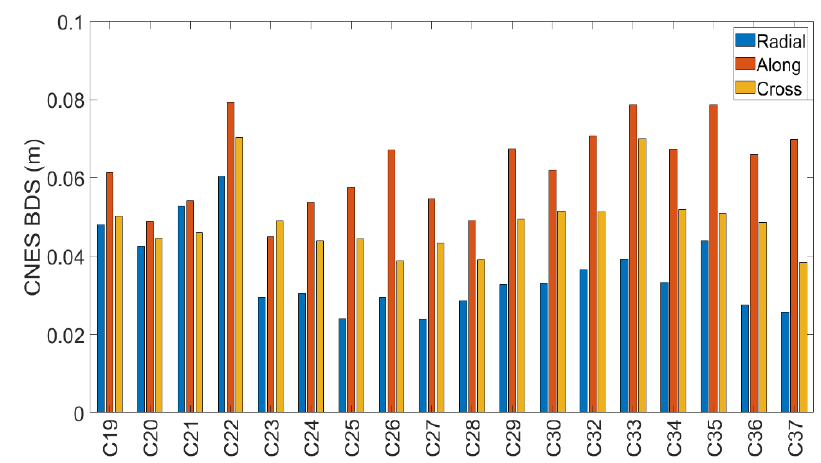
Figure 2. RMS values of GPS orbit errors for the CNES products.